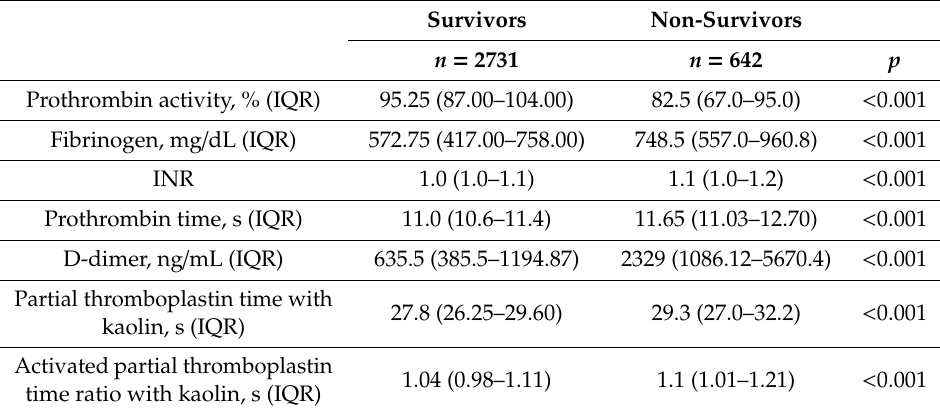
Table 2. Blood Coagulation Parameters between Survivors and